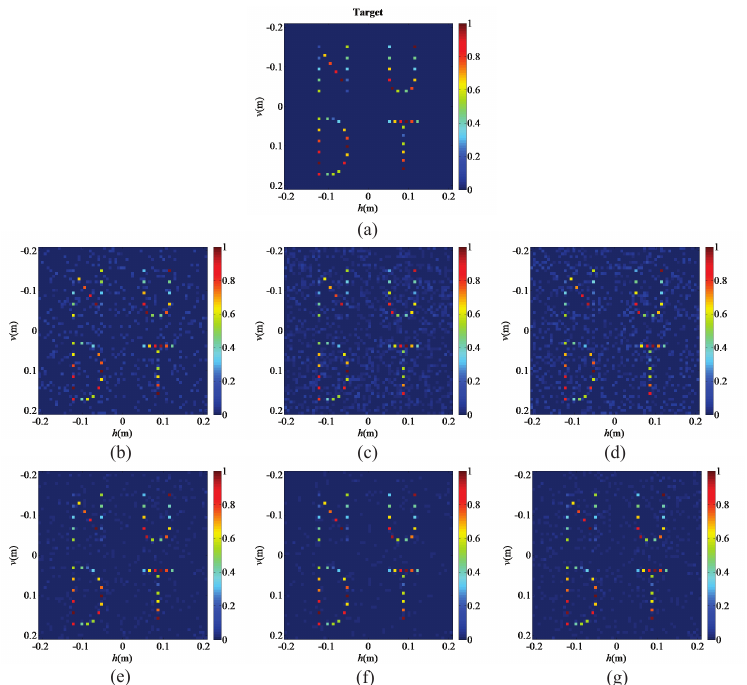
Figure 5. Reconstruction results for sparse target: ( a ) original sparse target; ( b ) OMP algorithm before compensation; ( c ) TVAL3 algorithm before compensation; ( d ) SBL algorithm before compensation; ( e ) OMP algorithm after compensation; ( f ) TVAL3 algorithm after compensation; ( g ) SBL algorithm after compensation.